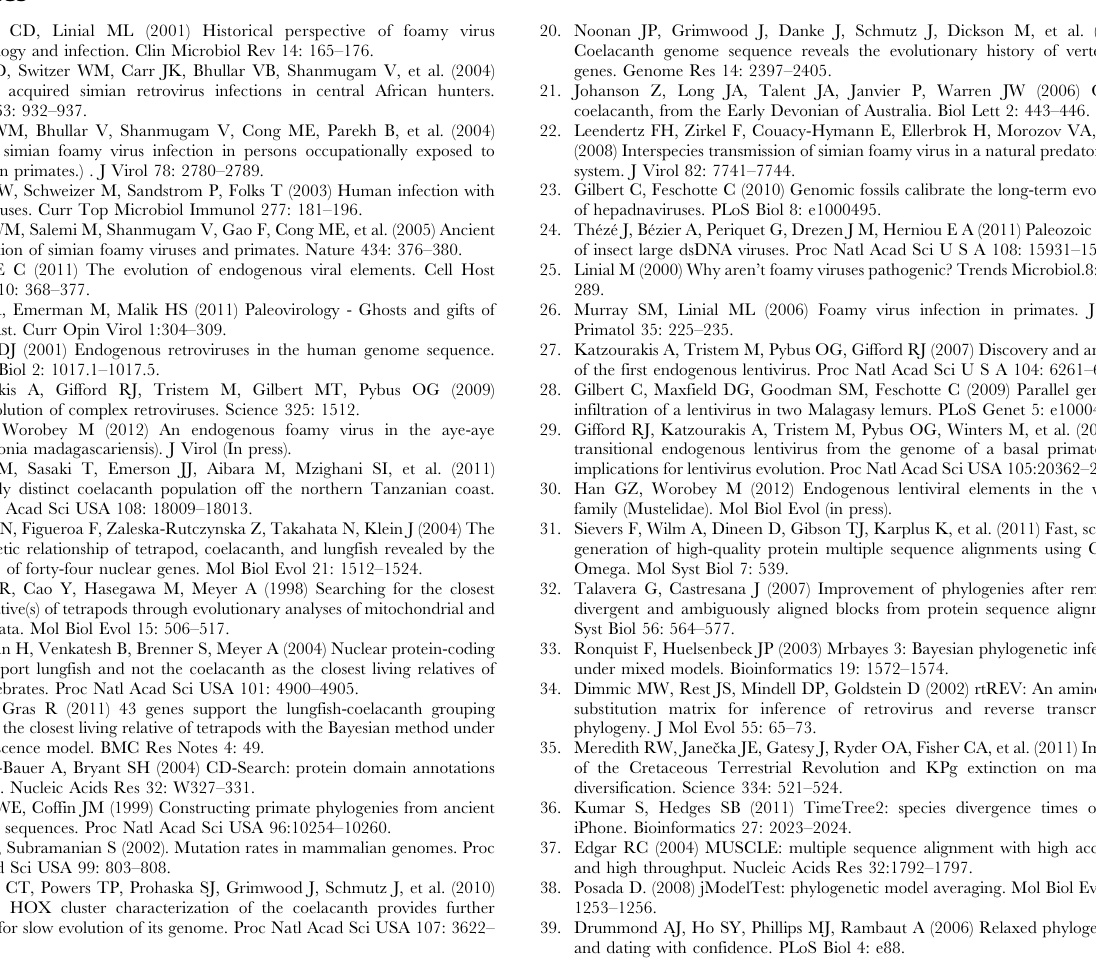
Table S2 The matching contigs identified in coelacanth genome.